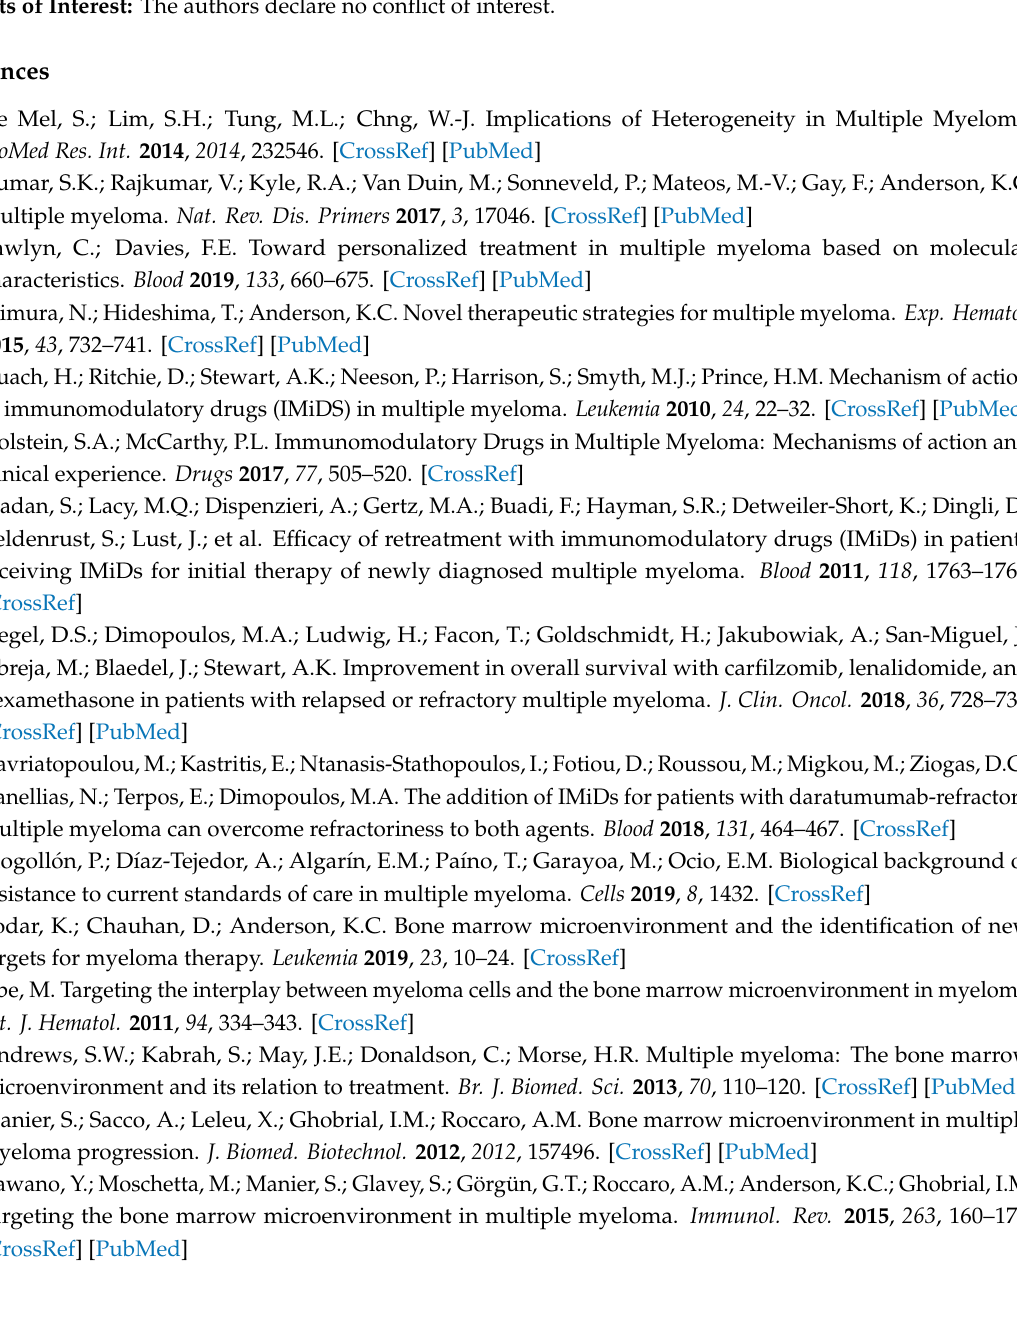
Figure S1: (A) Gating strategy of panel 1 for T cell and regulatory T cell analysis (B) Gating strategy of panel 2 for T cell and regulatory T cell analysis. (C) Gating strategy of panel 3 for MDSC analysis, Figure S2: Distribution of total T cells, their CD4 + and CD8 + counterparts, the CD4 / CD8 ratio, and NK / NKT frequency in the bone marrow (BM) and peripheral blood (PB) of MM patients at the time of diagnosis, Table S1: Clones and relative providers of antibodies used in the study, Table S2: Relative distribution of various immune subsets in paired bone marrow (BM) and peripheral blood (PB)